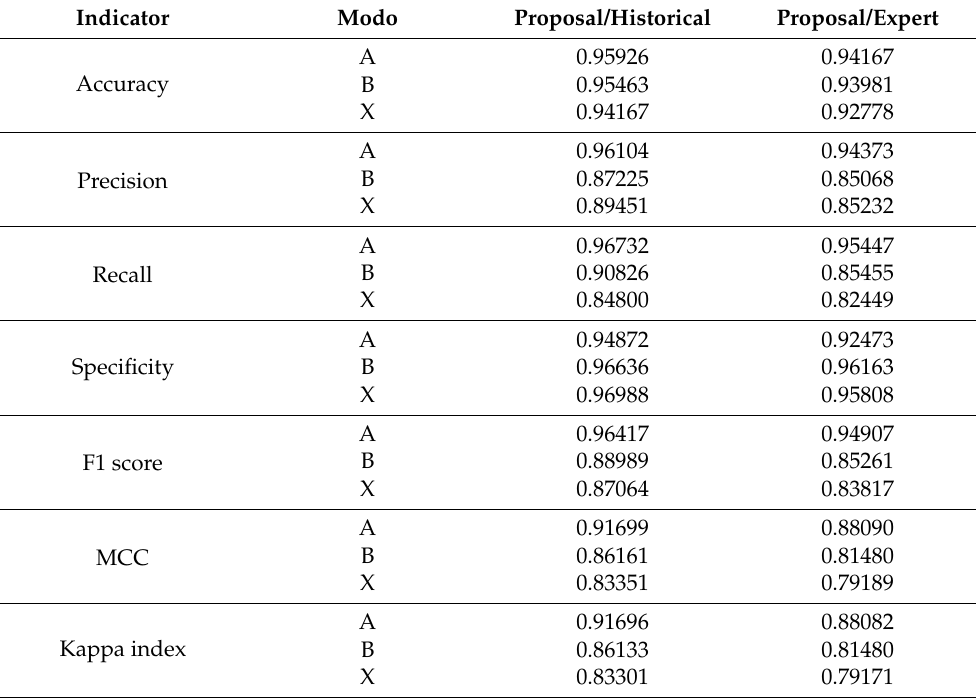
Table 5. Performance statistics of the proposed recommendation system versus historical data and domain